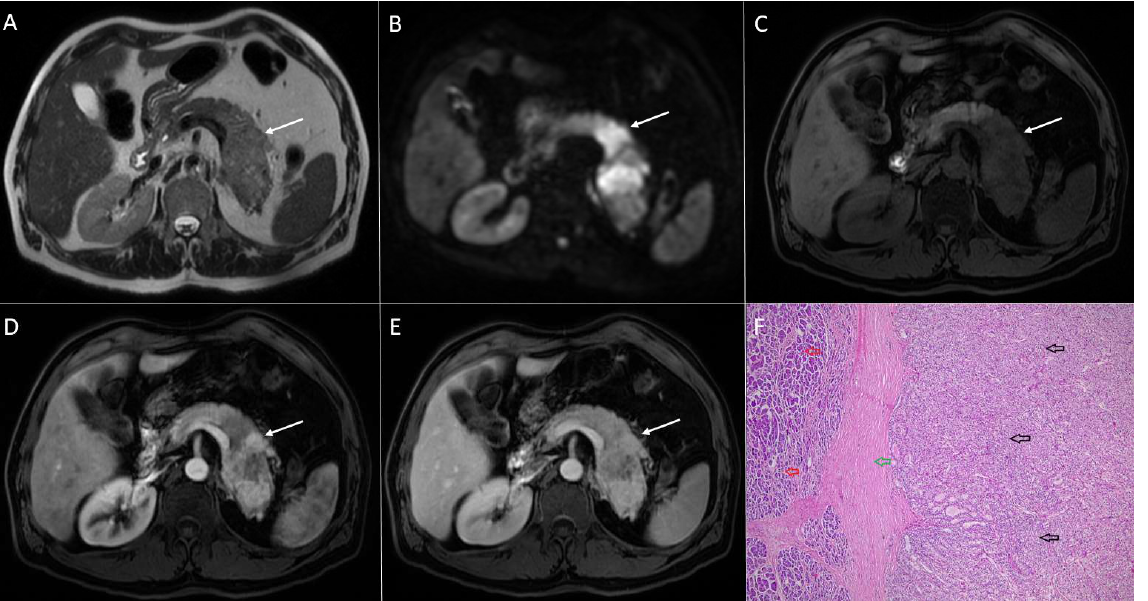
Figure 8. Pancreatic metastasis in 62-year-old man. T2-weighted image ( A ) shows slightly heterogeneous hyperintense lesion ( arrow ) in the pancreatic tail. On DWI ( B ), the tumor displays restricted diffusion. On T1-weighted FS image ( C ), the lesion ( arrow ) is hypointense. The lesion is well-vascularized in arterial ( D ) with persistent enhancement in portal-venous phase ( E ). Hematoxylin and eosin (H&E) staining ( F ) showed clear cell renal carcinoma metastasis ( black arrows ) and normal pancreatic parenchyma ( red arrows ) separated by fibrous pseudocapsula ( green arrow ) from the tumor; original magnification ×400.